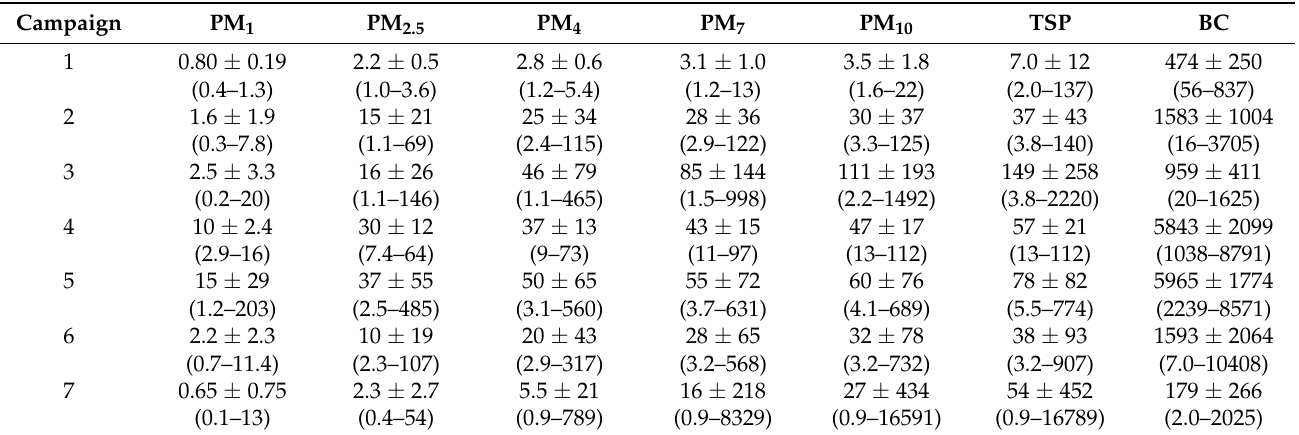
Table 2. Summary statistics (mean ± SD and range) of exposure concentrations of PM (µg/m 3 ) and BC (ng/m 3 ).